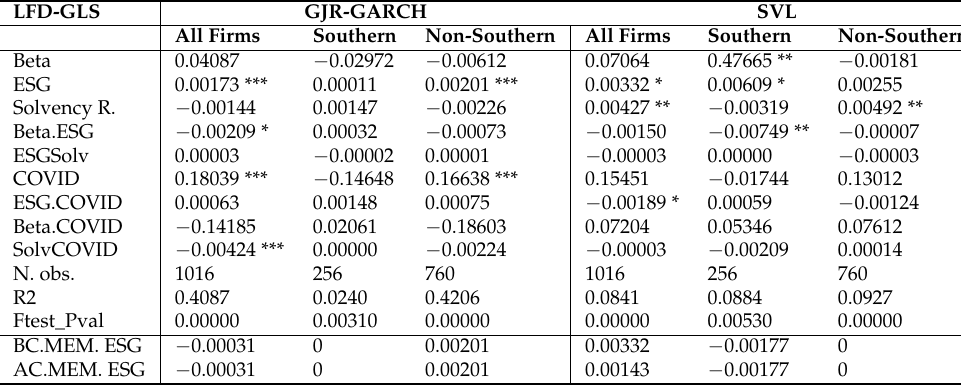
Table A2. LFD-GLS estimation results for all models, Part II.